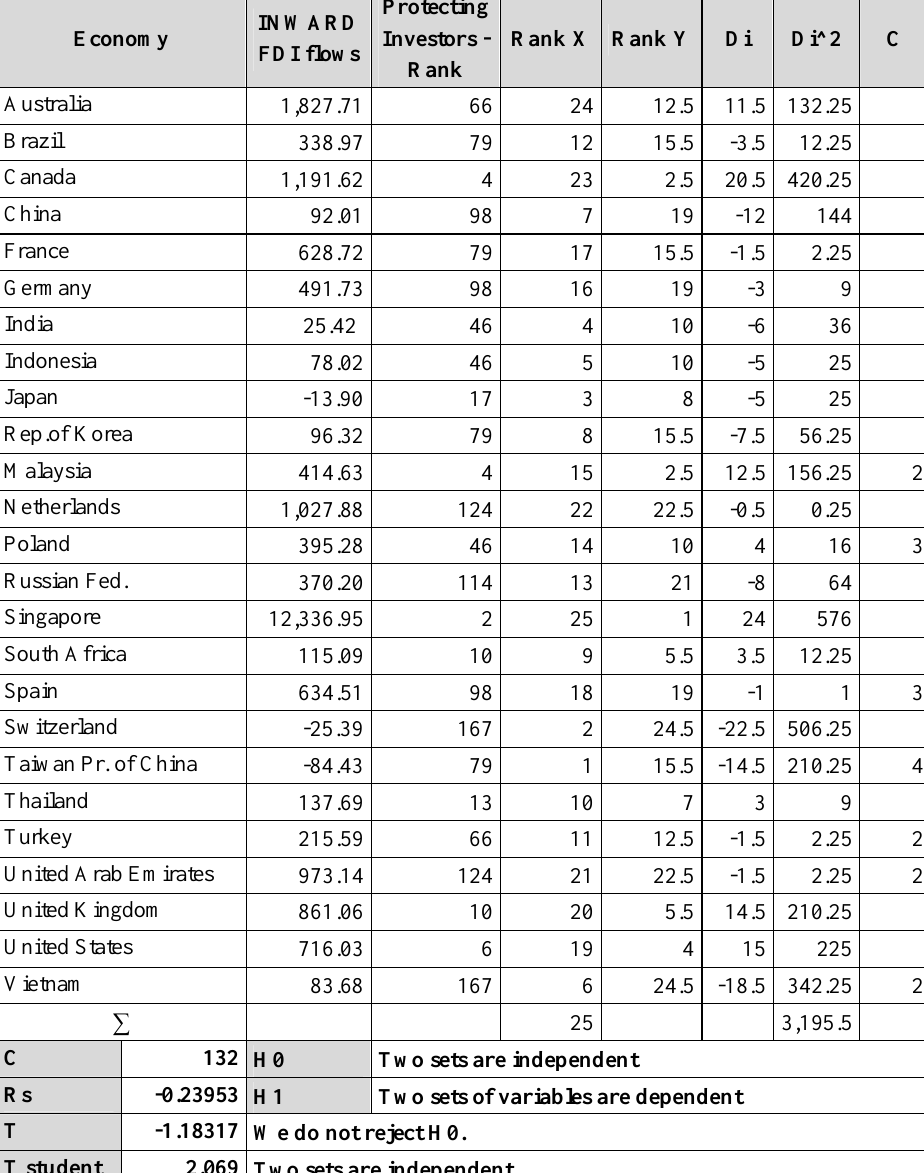
Table 3 – Testing of correlation of barrier “Protecting investors” and